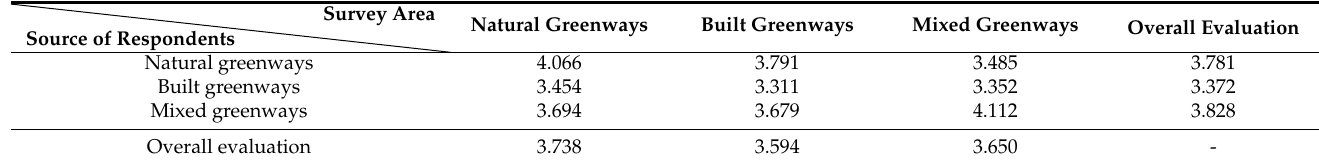
Table 6. Greenway perception matrix of different resident groups.